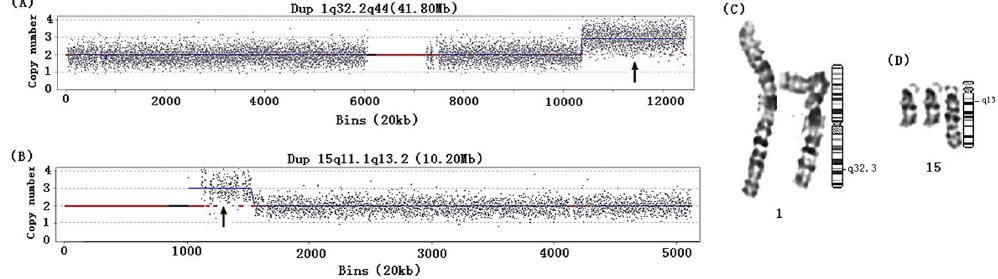
Figure 1. The CNV-seq profiles and partial karyograms of the fetus. ( A , B ) CNV-seq profiles for dup1q32.2q44 and dup15q11.1q13.2 (arrows), data is plotted as copy number (Y-axis) versus 20 kb chromosomal read bins (X-axis). The mean copy number along the length of each chromosome is indicated by the blue line. ( C , D ) The amniocytes of P20 showed partial karyotype and ideogram with an additional derivative chromosome der (15) t(1; 15) (q32.2;